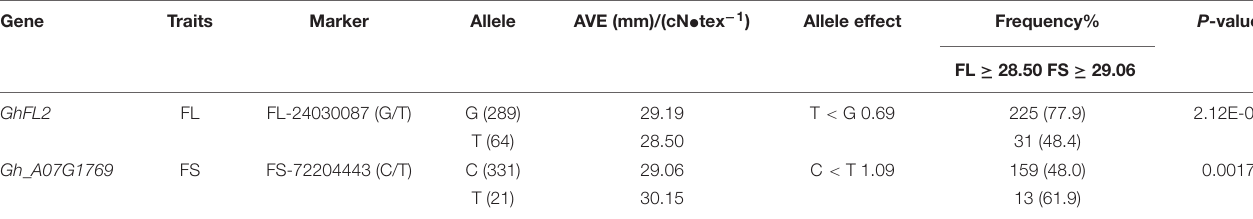
TABLE 3 | Allelic effects of genes underpinning FL and FS traits in the population of 360 accessions.